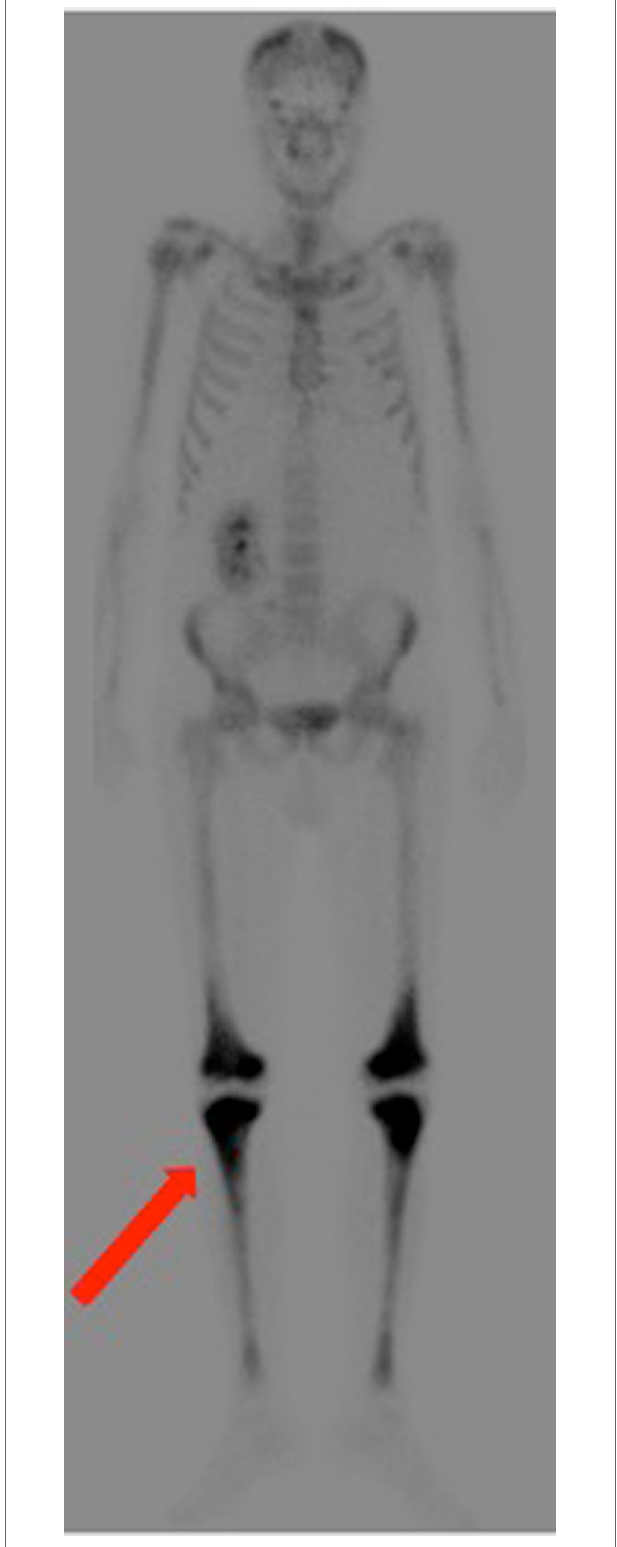
FIGURe 3 | Bone scan demonstrating symmetric diametaphyseal radiotracer uptake in the long bones of the lower limbs [ red arrow